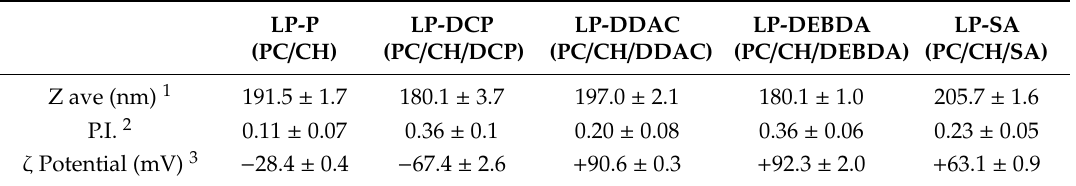
Figure 3. ( a ) macroscopic aspect of plain liposomes constituted by phosphatidyl choline/cholesterol (LP-P), dicetyl phosphate (LP-DCP), didecyldimethylammonium chloride (LP-DDAC), di isobutyl phenoxy ethyl dimethyl benzyl ammonium chloride (LP-DEBDA) and stearylamine (LP-SA) and representative electron microphotographs of ( b ) plain (LP-P), ( c ) anionic (LP-DCP) and ( d ) cationic (LP-DDAC) liposomes. Table 2. Size and zeta potential of liposome formulations after production, as determined by photon correlation spectroscopy (PCS).